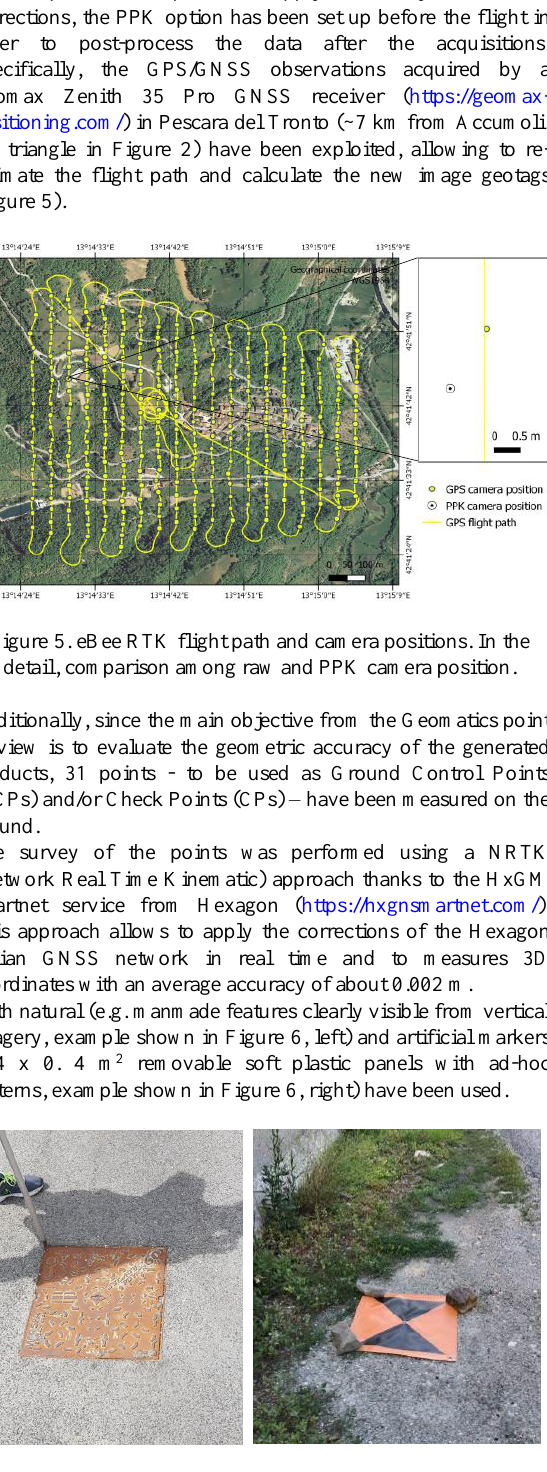
Figure 6. Examples of existing (left) and artificial (right) markers measured on the ground and used as GCP and/or CP.